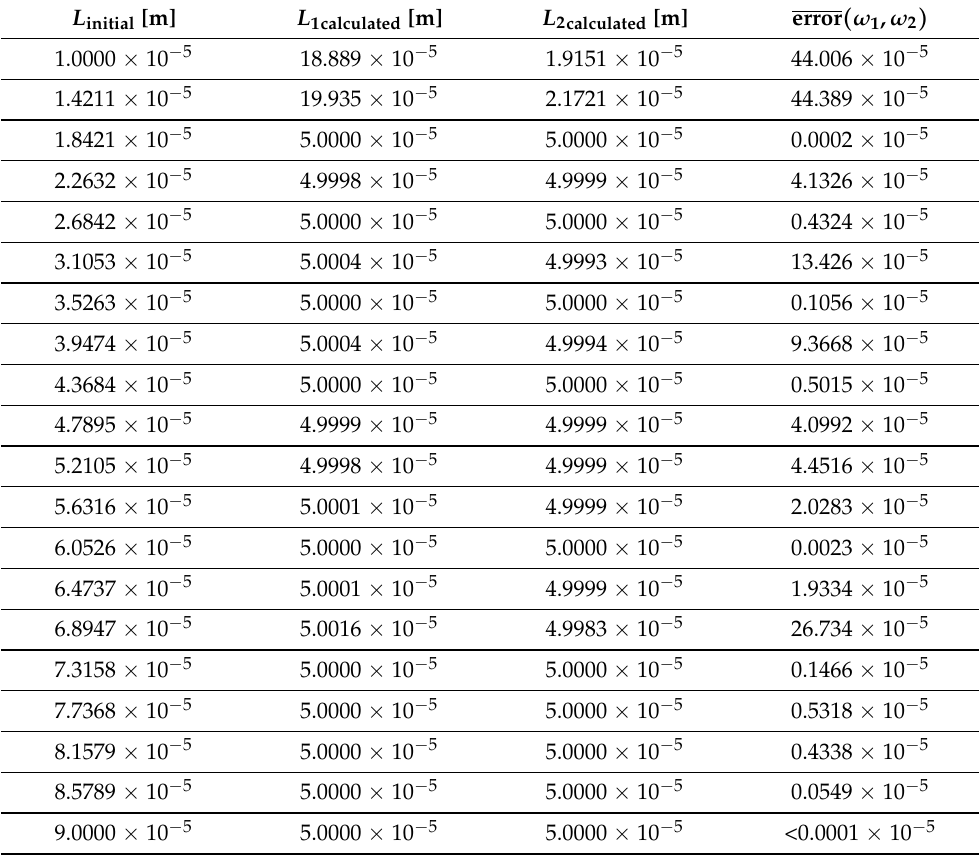
Table 7. Results for case